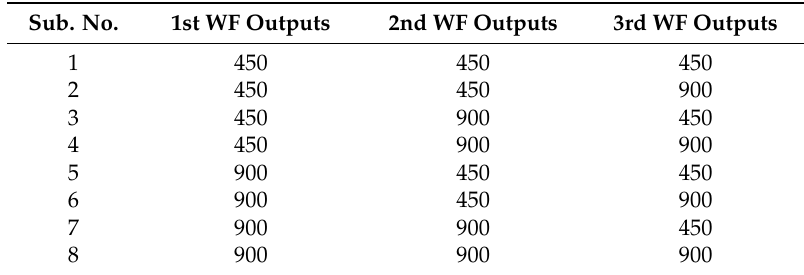
Table 5. The Subspaces with different WF